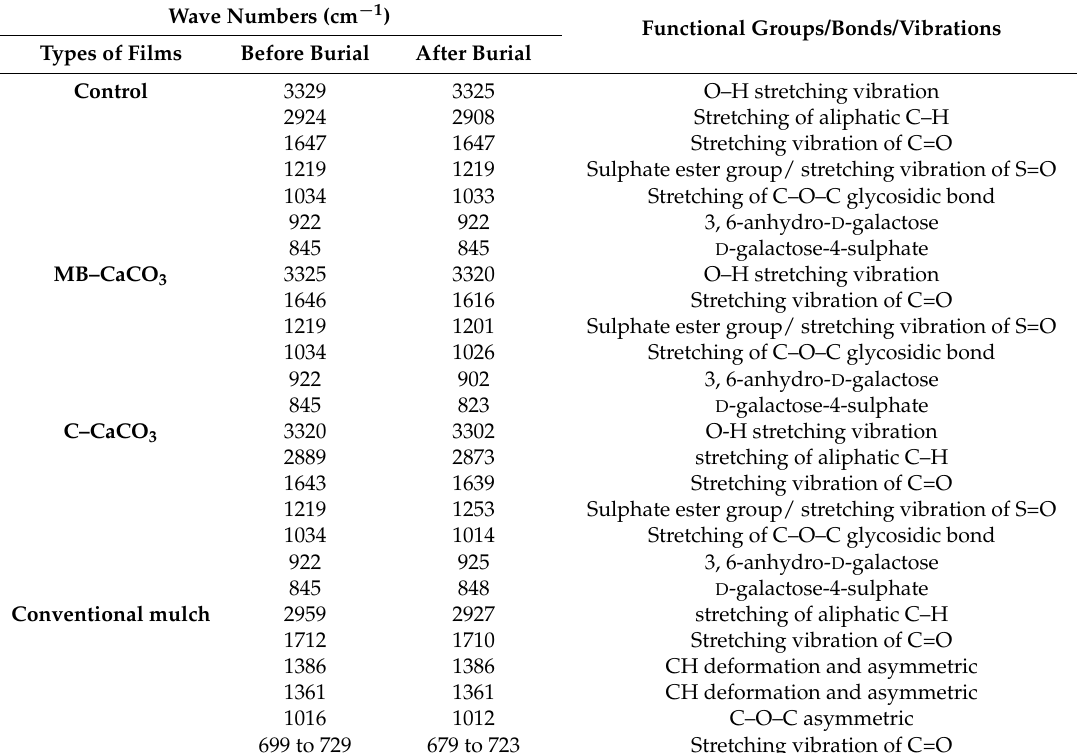
Table 5. Functional groups, bonds, and vibrations of seaweed-based films and conventional